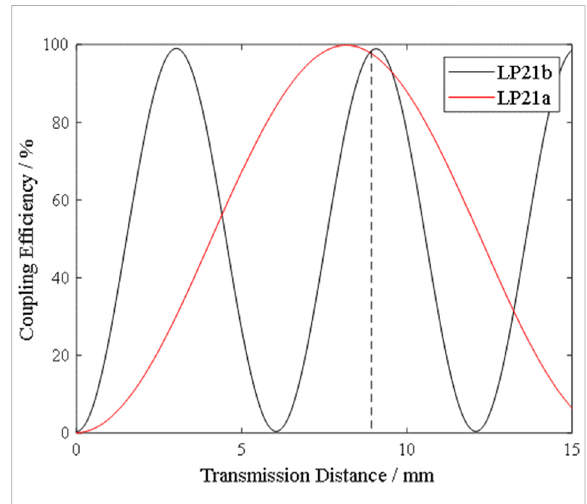
FIGURE 4 Variation of coupling ef fi ciency of the output modes